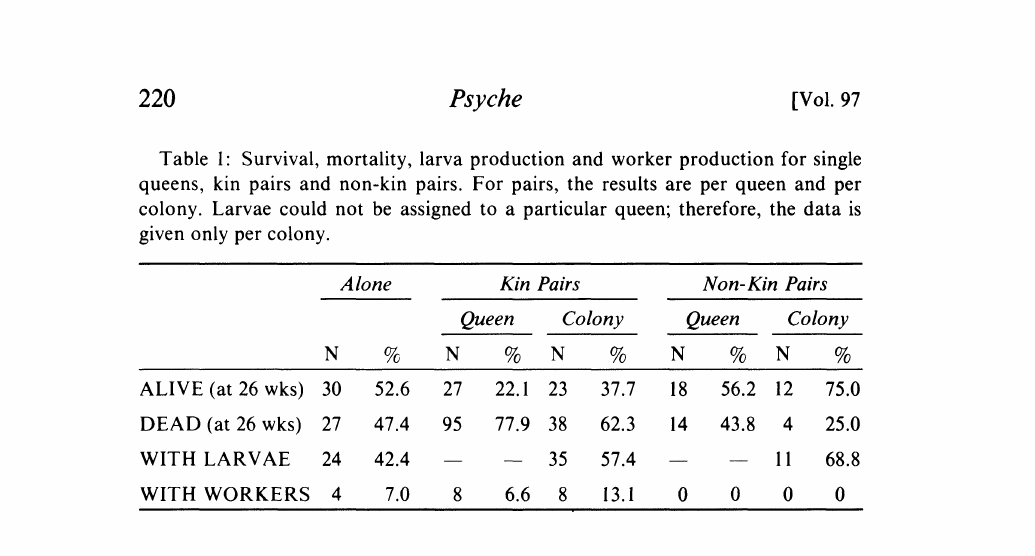
Table 1: Survival, mortality, larva production and worker production for single queens, kin pairs and non-kin pairs. For pairs, the results are per queen and per colony. Larvae could not be assigned to a particular queen; therefore, the data is given only per